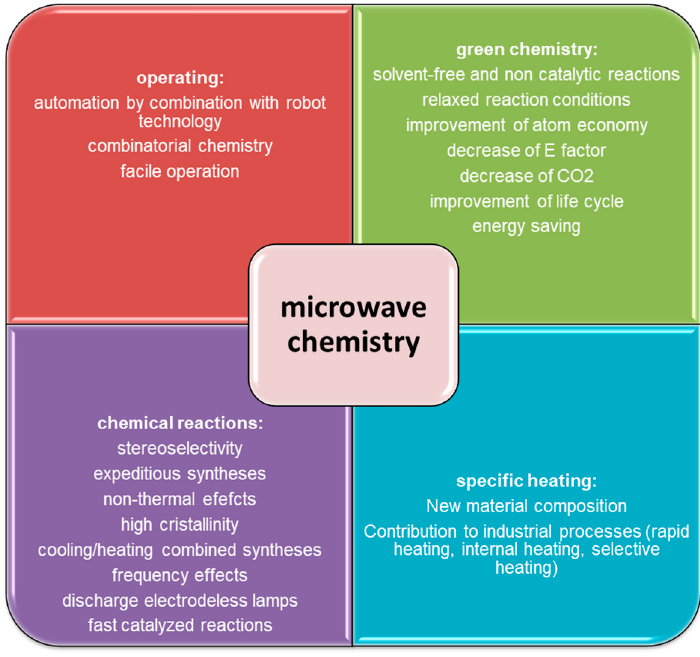
Figure 1. The role of microwave radiation in microwave chemistry [8].